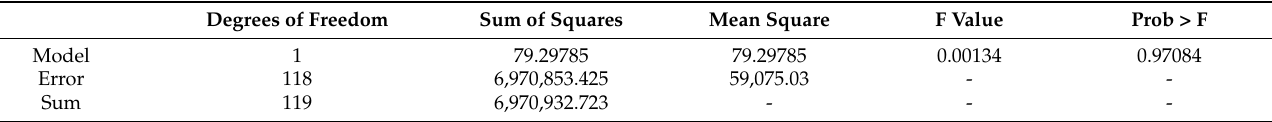
Figure 7. Calculated strain vs. measured strain. Table 4. Results of one-way analysis of variance between calculated and measured offsets.